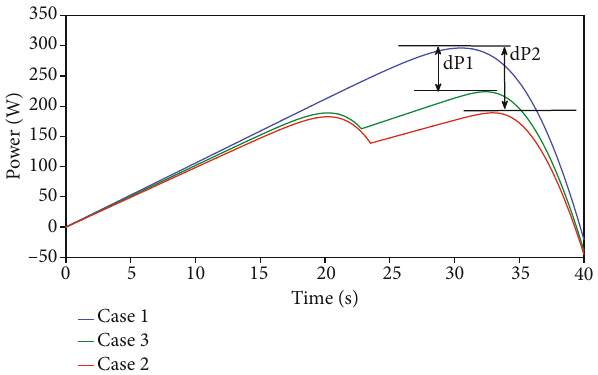
Figure 4: P-V characteristic curves for uniform irradiance and partial shading conditions.